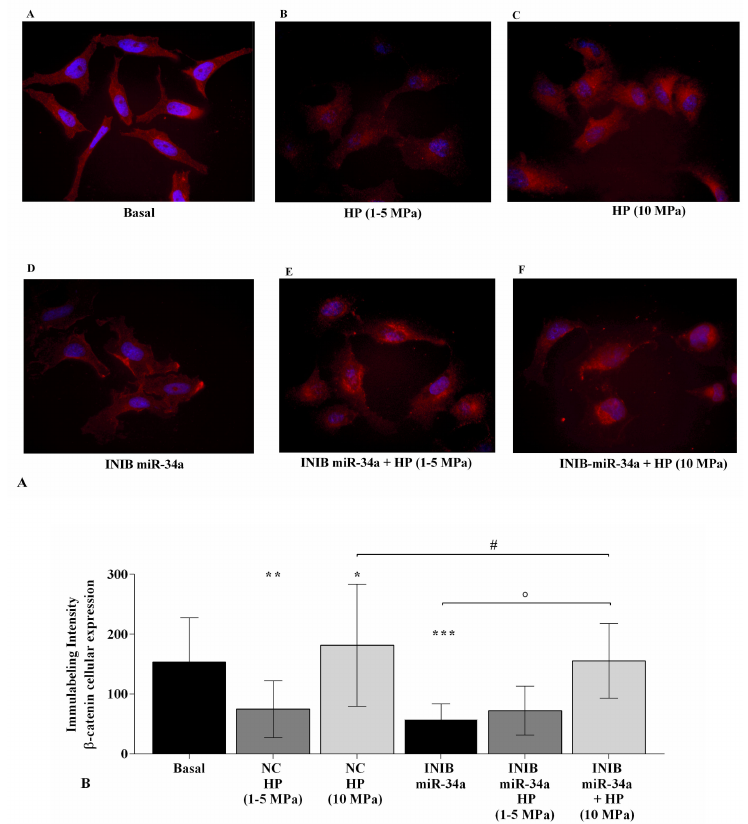
Figure 9. miR-34a inhibition mediates HP e ff ect on β -catenin protein expression. Immunofluorescence labeling of β -catenin localization. Human OA chondrocytes were evaluated at basal condition, after 24 h of transfection with miR-34a inhibitor, and after 3 h of low sinusoidal (1–5 MPa) or static continuous (10 MPa) HP exposure. ( A ) Representative immunocytochemical images of the cells showing localization of β -catenin (red); nuclei were stained with DAPI (blue). Original magnification 400 × . Scale bar: 20 µ m. ( B ) The histogram of immunolabeling intensity was plotted for the nuclear and cytoplasm expression for β -catenin. Data were expressed as mean ± SD of triplicate values. * p < 0.05, ** p < 0.01, *** p < 0.001 versus basal condition. ◦ p < 0.05 versus inhibitor. # p < 0.05 versus HP. INIB =